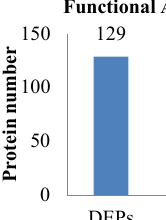
Figure 6. Statistical results of different functional annotations.